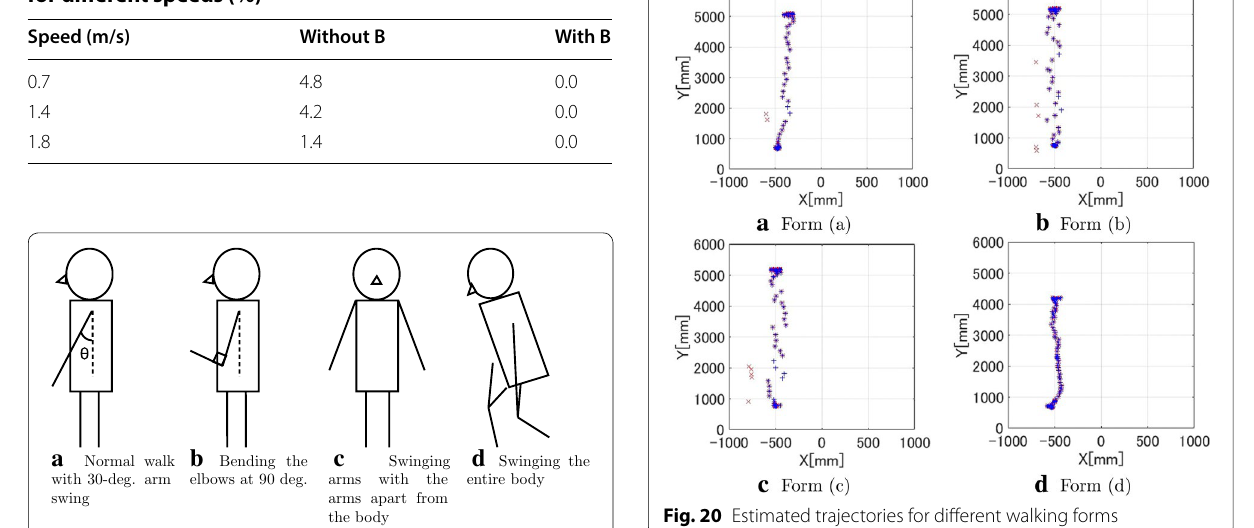
Fig. 19 Four forms examined in the experiment